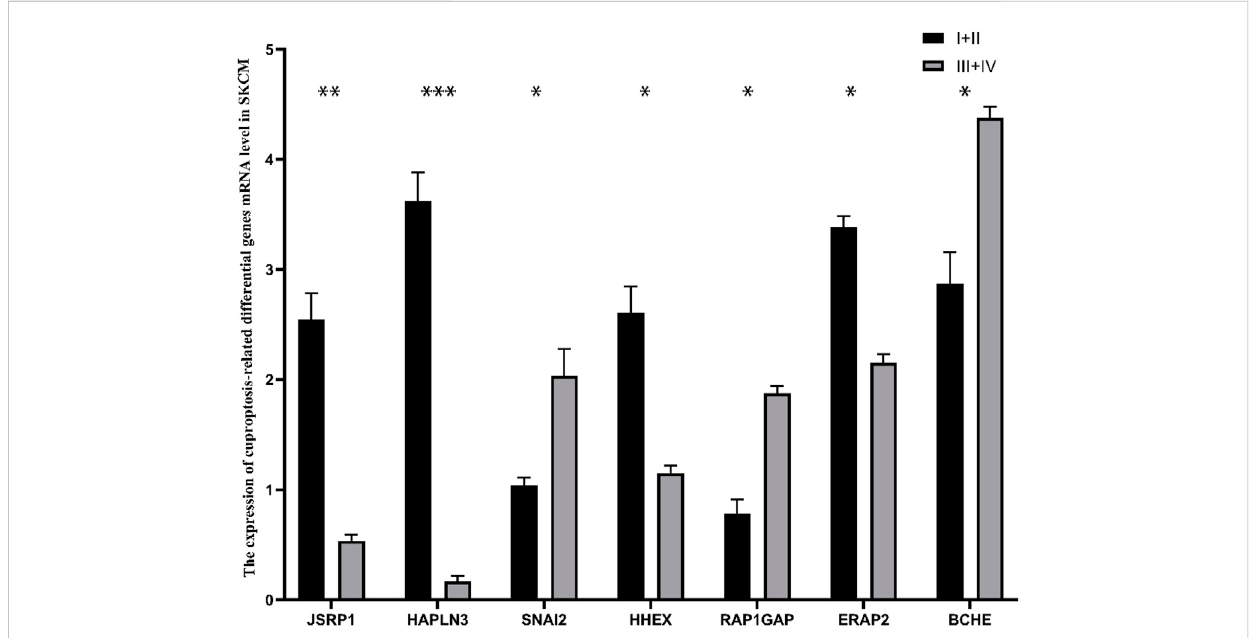
FIGURE 11 The mRNA expression of 7 cuproptosis-related differential genes in patients with different stages of cutaneous melanoma. * p < 0.05, ** p < 0.01, *** p <